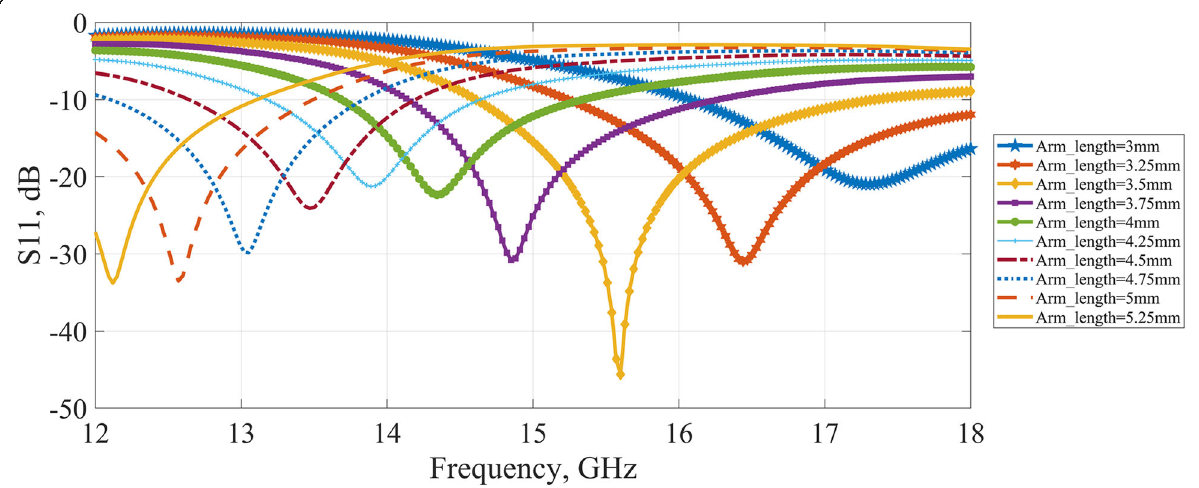
Fig. 2 Variation of frequency response with dipole arm